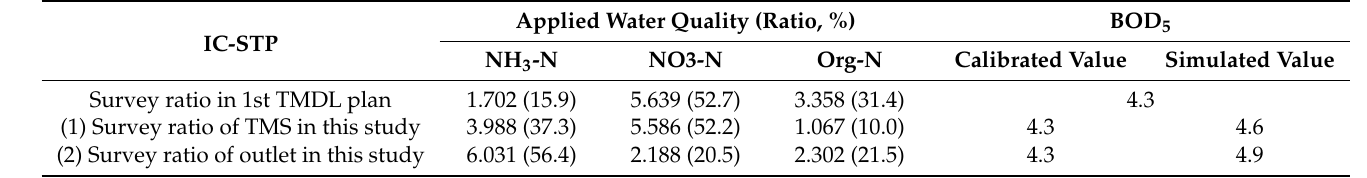
Table 8. Effects of nitrogen ratio change in the STP effluent on BOD.